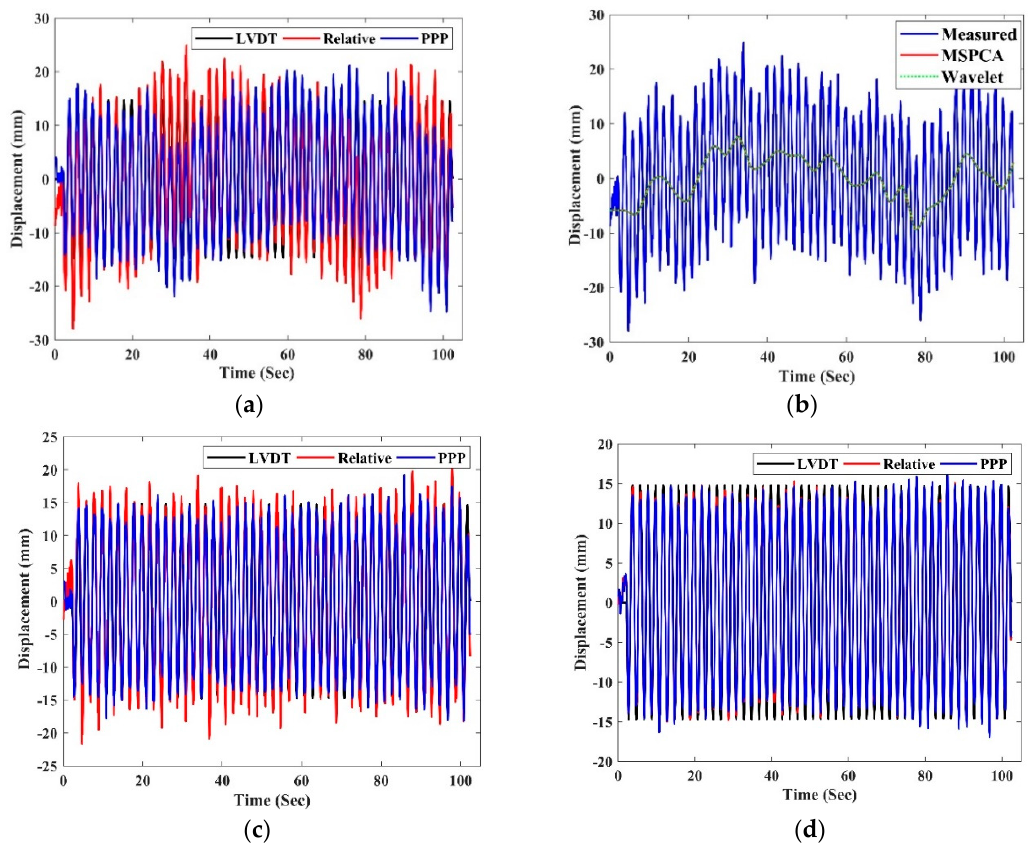
Figure 8. MSPCAW evaluation in amplitude, ( a ) apparent displacement, ( b ) relative measurement filter, ( c ) short-period component, and ( d ) dynamic component.